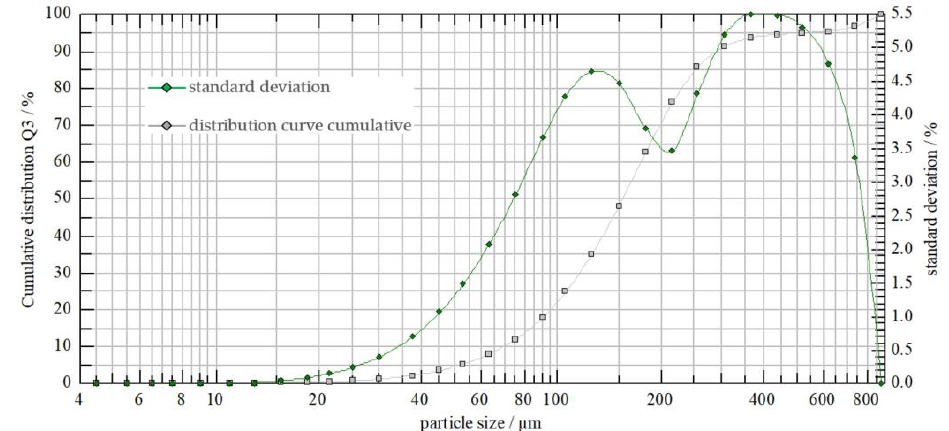
Figure 3. AP12003 sprayer’s droplet spectrum at a pressure of 0.40 MPa.